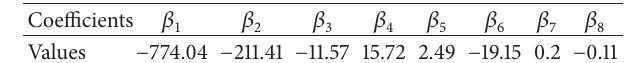
Table 2: Regression coefficients of the PWV retrieval algorithm applied only when using 18.7 and 23.8 GHz with horizontal polar-